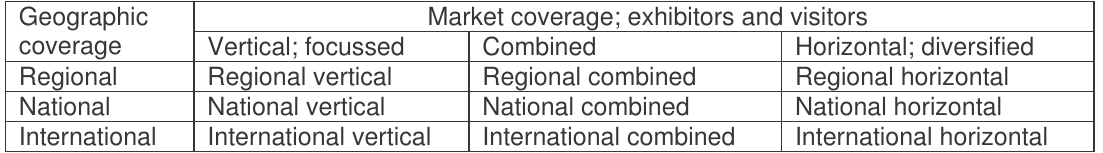
Table 1: Types of industrial trade shows Market coverage; exhibitors and visitors Geographic coverage Vertical; focussed Combined Horizontal; diversified Regional Regional vertical Regional combined Regional horizontal National National vertical National combined National horizontal International International vertical International combined International